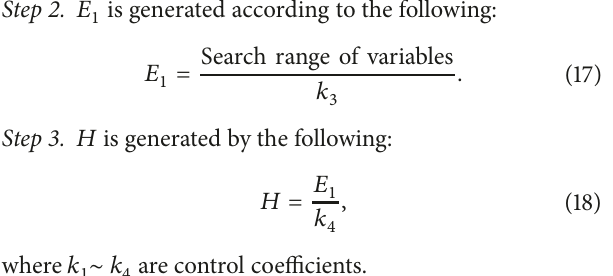
where ‖ ⋅ ‖ indicates Euclidean distance after unitization processing; therefore, 0 ≤ ‖ ⋅ ‖ ≤ 1 . Obviously, the smaller the antibodies are, the more similar they will be and the stronger the inhibition will be, and, hence, the smaller 𝜑 𝑖 will